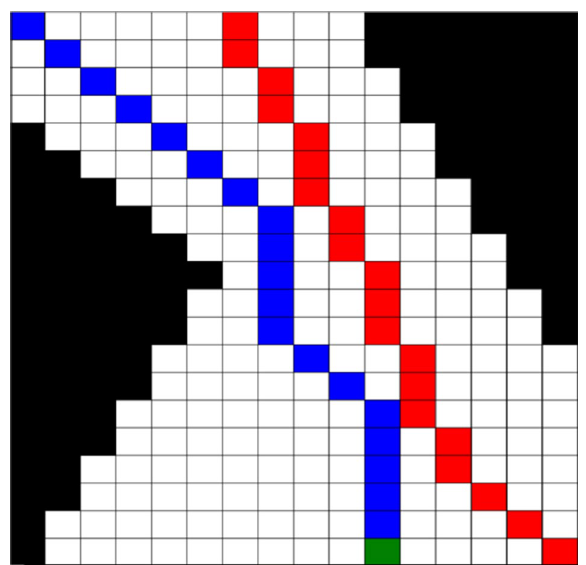
Fig. 16 Path planning results of FCC-A*. The planning results of the FCC-A* algorithm are shown in this figure. The FCC-A* algorithm considers the collision field between the give-way ship and the direct-sailing ship, and the collision risk is incorporated into the cost function of the A* algorithm as a membership function. Therefore, the give-way ship will consider the cost of collision with the direct-sailing ship in every step, thereby avoiding the risk of collision